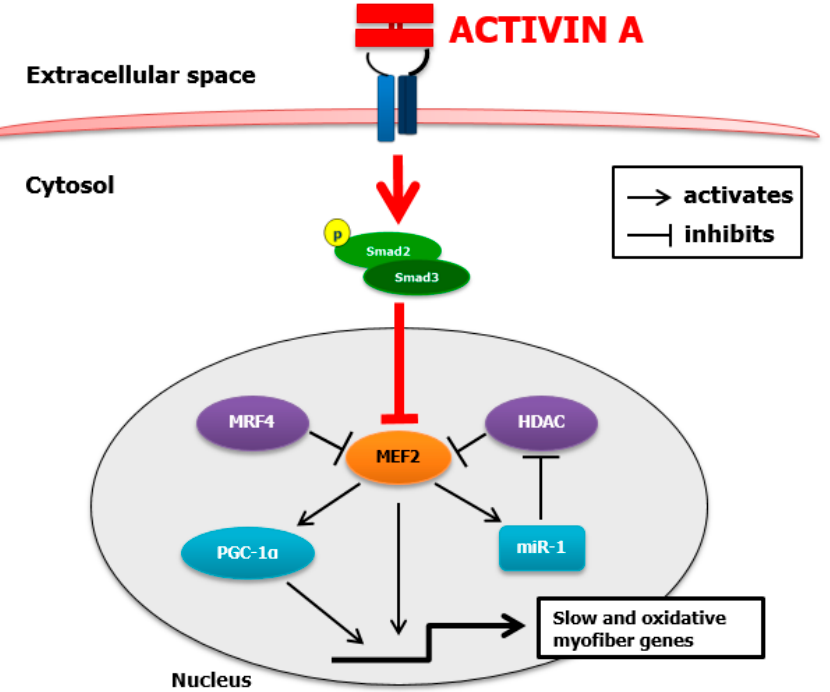
Figure 7. In muscle cells, activin A inhibits MEF2C expression and activity, leading to an inhibition of myosin-heavy chain- β /slow synthesis and muscle atrophy. Activin A, through activation and phosphorylation of Smad2/3, downregulates MEF2C expression and activity, leading to a decrease in MEF2C target expression ( MYH7 , peroxisome proliferator-activated receptor- γ activator- α (PGC-1 α ); microRNA (miR)-1), causing a decrease in MyHC- β /slow synthesis and muscle atrophy. ActA does not alter expression of negative regulators of MEF2C, such as myogenic regulatory factor 4 (MRF4) or class II histone deacetylases